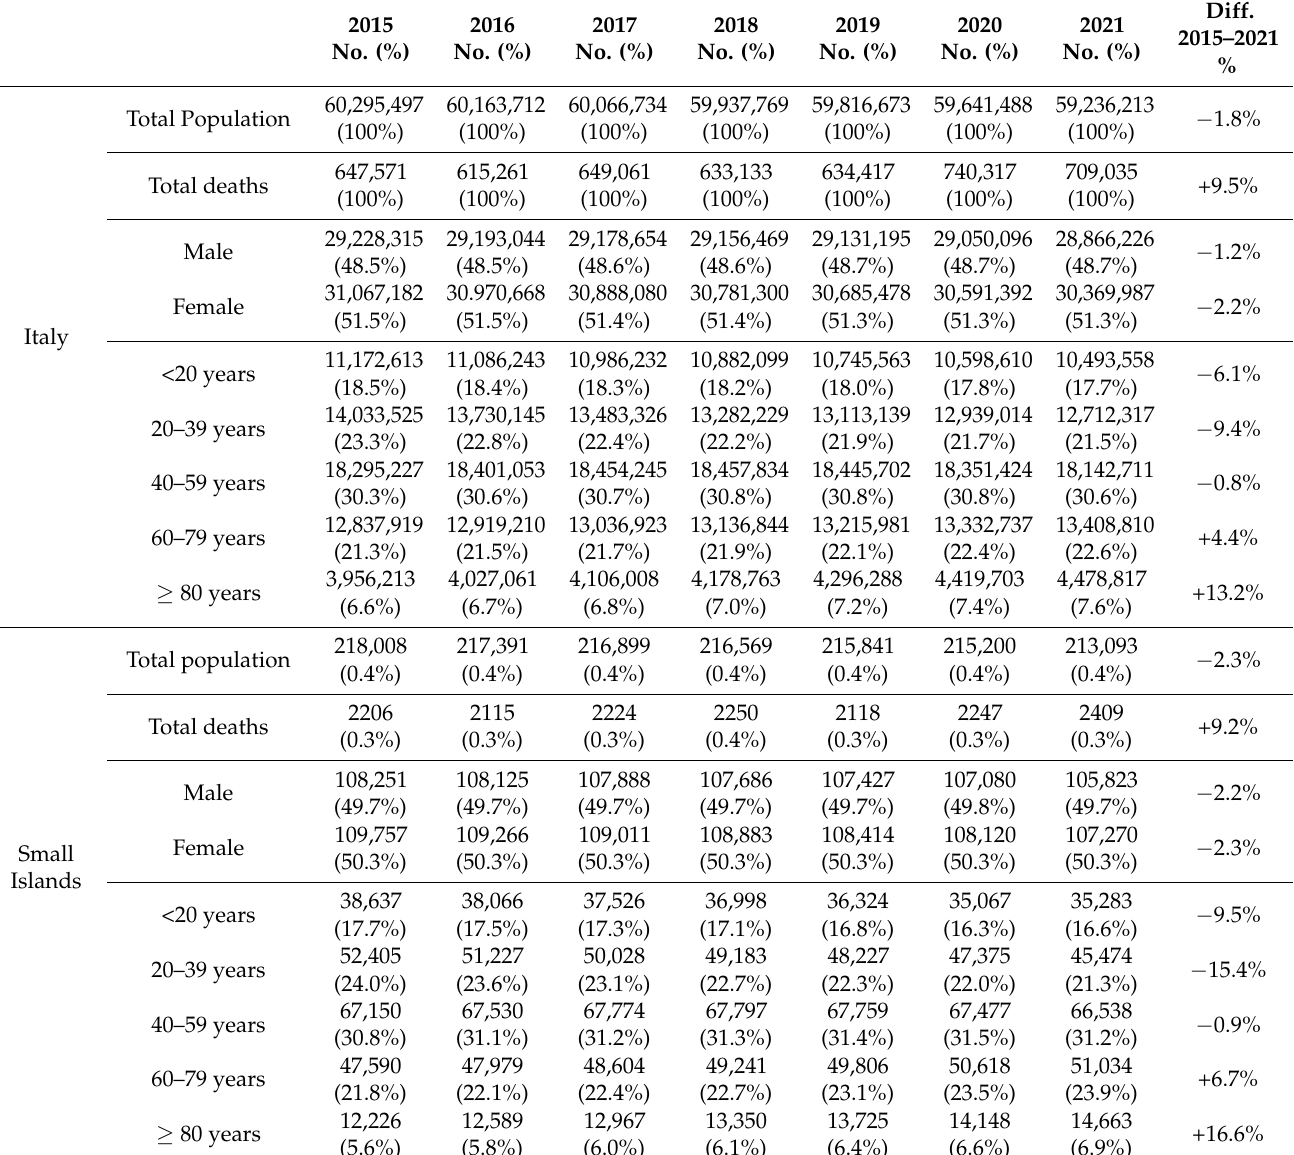
Table 1. Demographics of the 35 counties from Italian small Islands (2015–2021) compared to